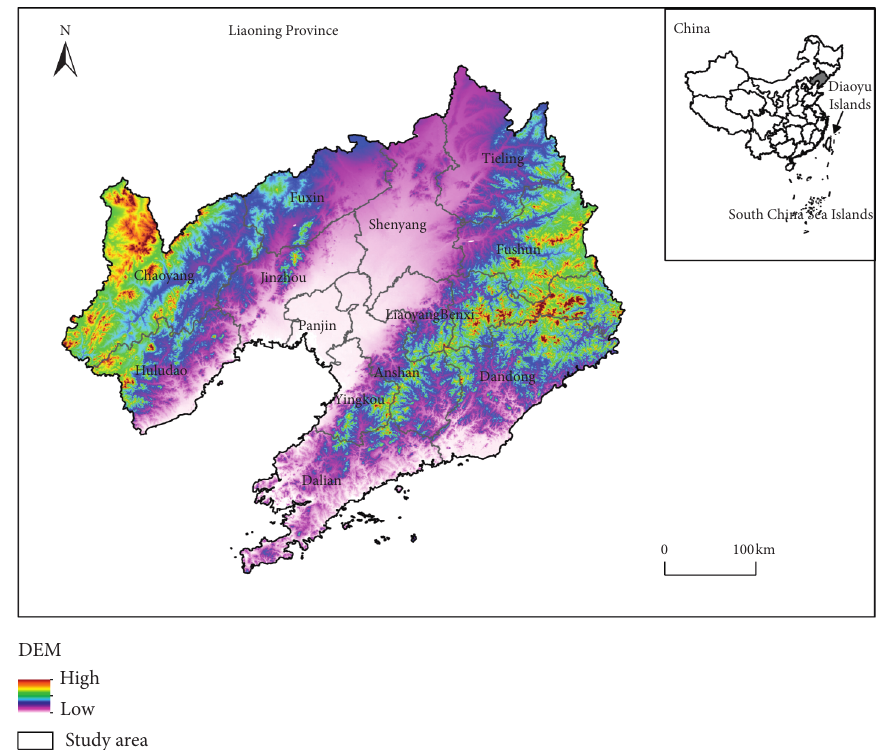
Figure 1: The location of the study area.